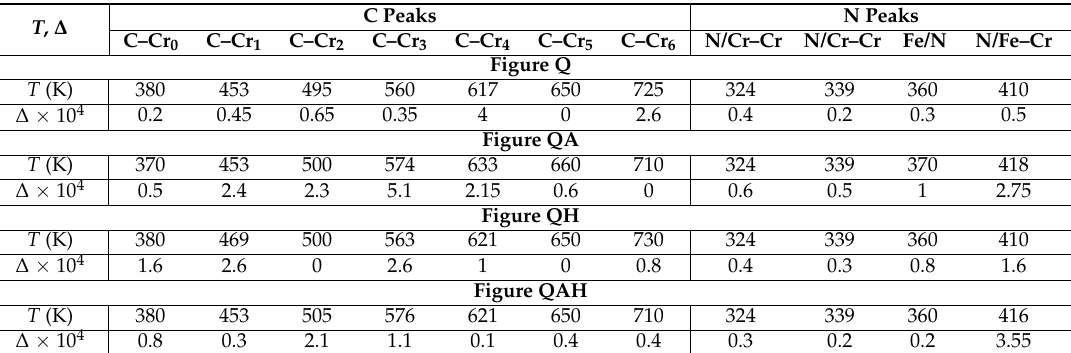
Table 5. Temperatures T and relaxation strengths ∆ of the Q − 1 peaks used to fit MS experimental data displayed in Figure 8, for the samples quenched (Q), quenched and H-permeated (QH), quenched and annealed (QA), and quenched, annealed, and H-permeated (QAH). Data of the quenched (Q) steel (Table 3) are also reported for comparison.